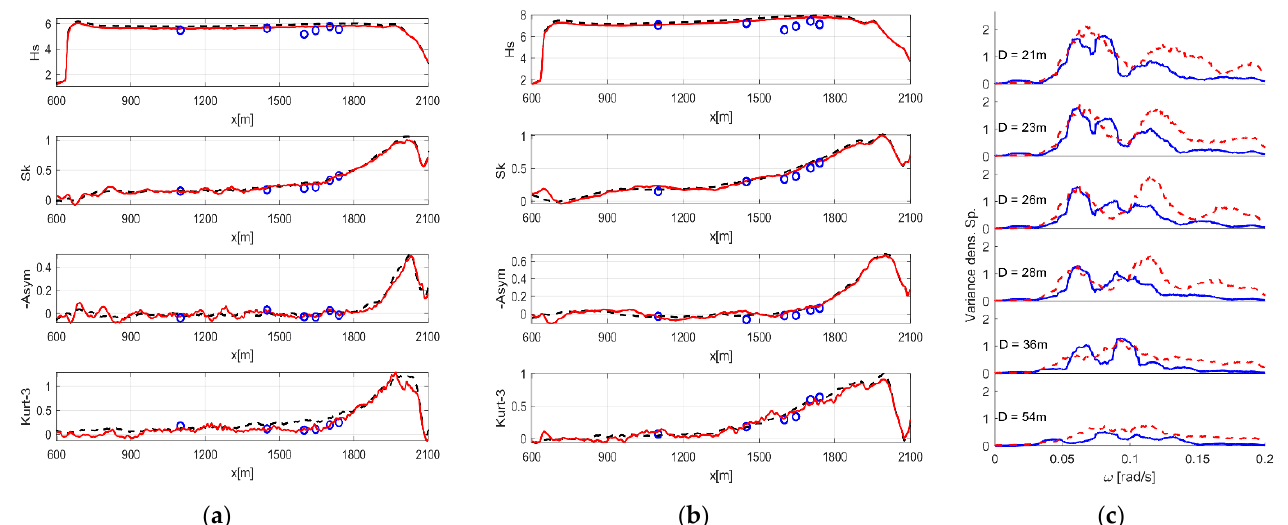
Figure 2. Plots of the value of Hs, Skewness, Asymmetry, and excess-Kurtosis over the domain in ( a ) for H6T12 and in ( b ) for H7.5T16 with bottom friction. Circles provide the value of the measurement and the solid red curve provides the values of the simulation. The black dashed line is the result of simulations for a four-times-longer simulation time. In ( c ), Infra-Gravity spectra of the experimental data (blue solid) and the simulation data (red-dashed) are shown for H7.5T16 at different depths.